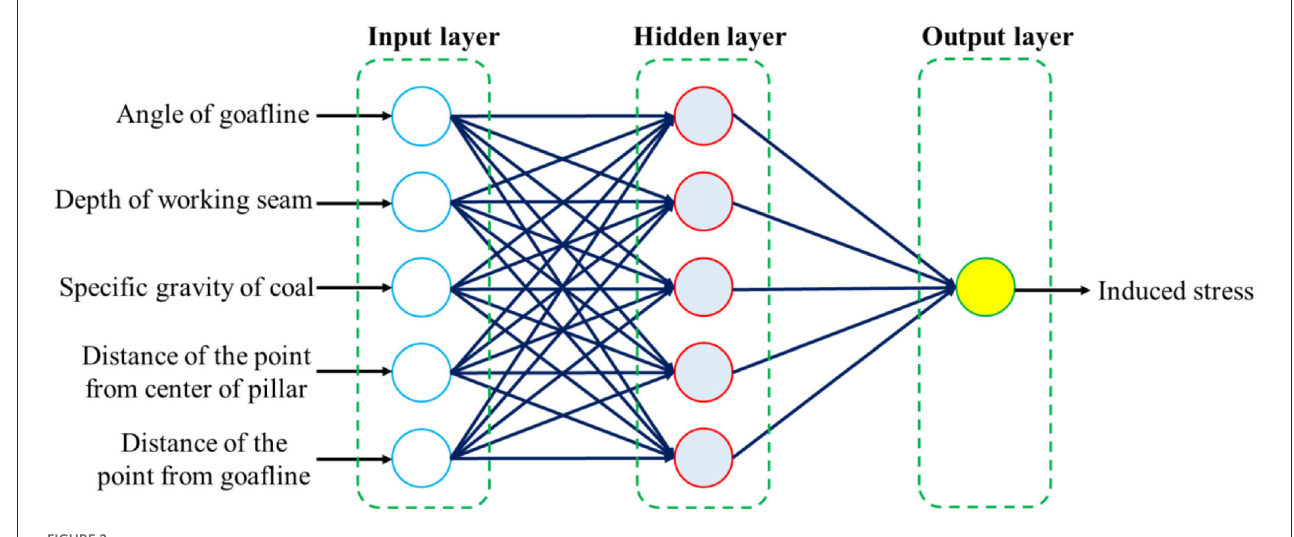
FIGURE2 BPNN model framework for estimating induced stress.